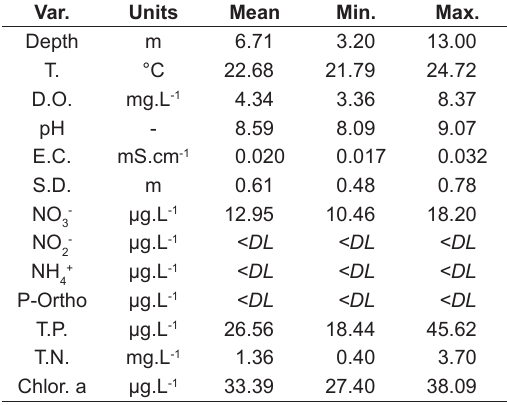
Table 3. Data from physicochemical analyzes obtained index to 2 in the field and posterior laboratory analysis.